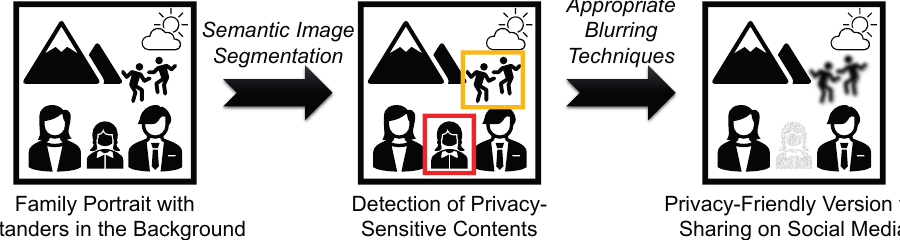
Figure 12. A Process for Making Privacy-Friendly Versions of Portraits with Sensitive Content. Initially, the original image is analyzed using deep learning. In this process, the deep features are extracted, i.e., the components that are significant for the recognition of the depicted objects in the underlying model. Based on these deep features, the image is then partitioned into a set of semantic object regions. These regions describe connected areas on the image, e.g., a person, an animal, or an object, while background objects are ignored. Using a classification, all of these regions are then assigned to a semantic meaning, e.g., bystander or child. For these classes, a privacy sensitivity is determined, which indicates how much the respective object needs to be protected [149]. In our example, bystanders receive the protection level orange, while children receive the protection level red. For persons, the semantic region can also be restricted to the face since this usually has the highest privacy sensitivity. To this end, face detection can be used to determine the region to be masked. Depending on the level of protection required, different techniques can be used that affect the visual quality of the image to a greater or lesser extent, e.g., blanking, scrambling, or blurring [150]. This way, a privacy-friendly version of the image suitable for social media can be